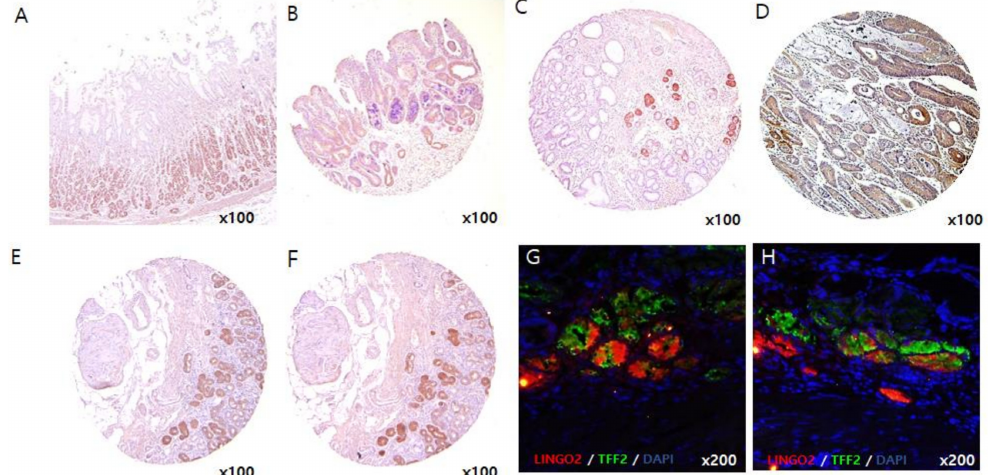
Figure 6. LINGO2 expression in ( A ) normal gastric tissue, ( B ) gastric polyp, ( C ) SPEM, and ( D ) gastric cancer tissues. Immunohistochemical staining of ( E ) LINGO2 expression and ( F ) TFF2, SPEM marker, with serially sectioned slides and ( G , H ) co-immunofluorescence staining of LINGO2 and TFF2 in separate patient tissue slides (LINGO2: red, TFF2: green, DAPI: